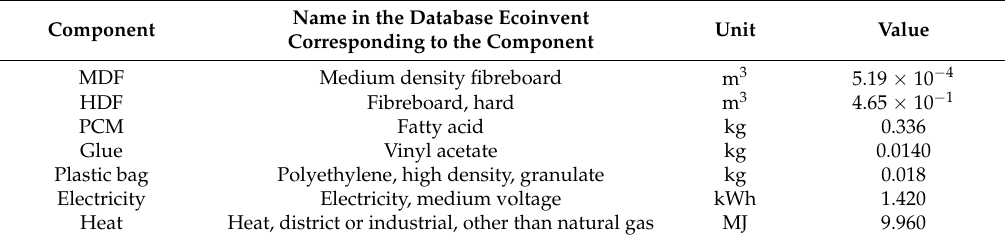
Table 2. Inventory data for one PCM panel